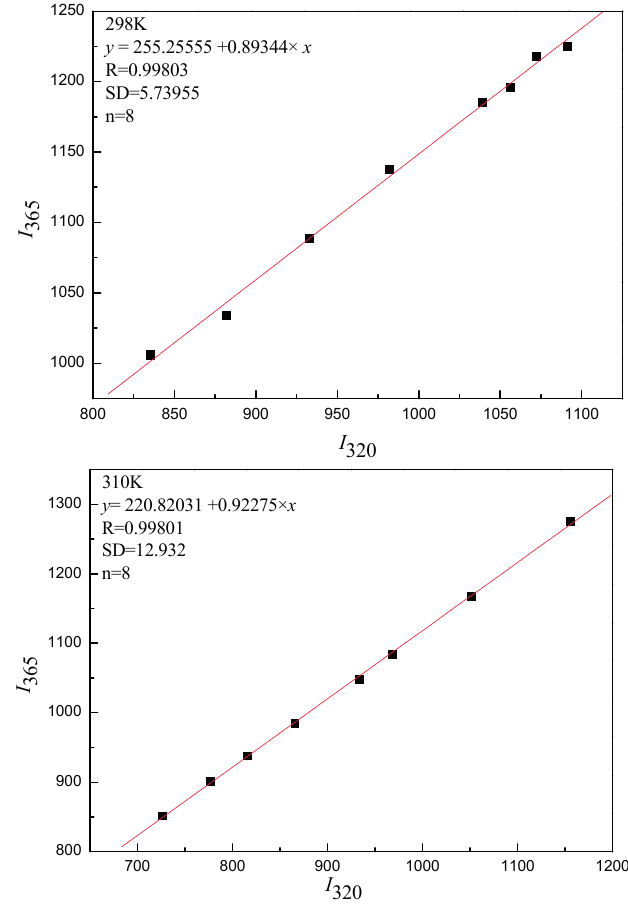
Figure 7. The fluorescence phase diagrams of GA-LYS. c LYS = 1.0 × 10 − 5 mol/L, c GA (1 to 8) = 0.0, 0.4, 0.8, 1.6, 2.8, 3.6, 4.8, 5.6 (×10 − 5 mol/L).